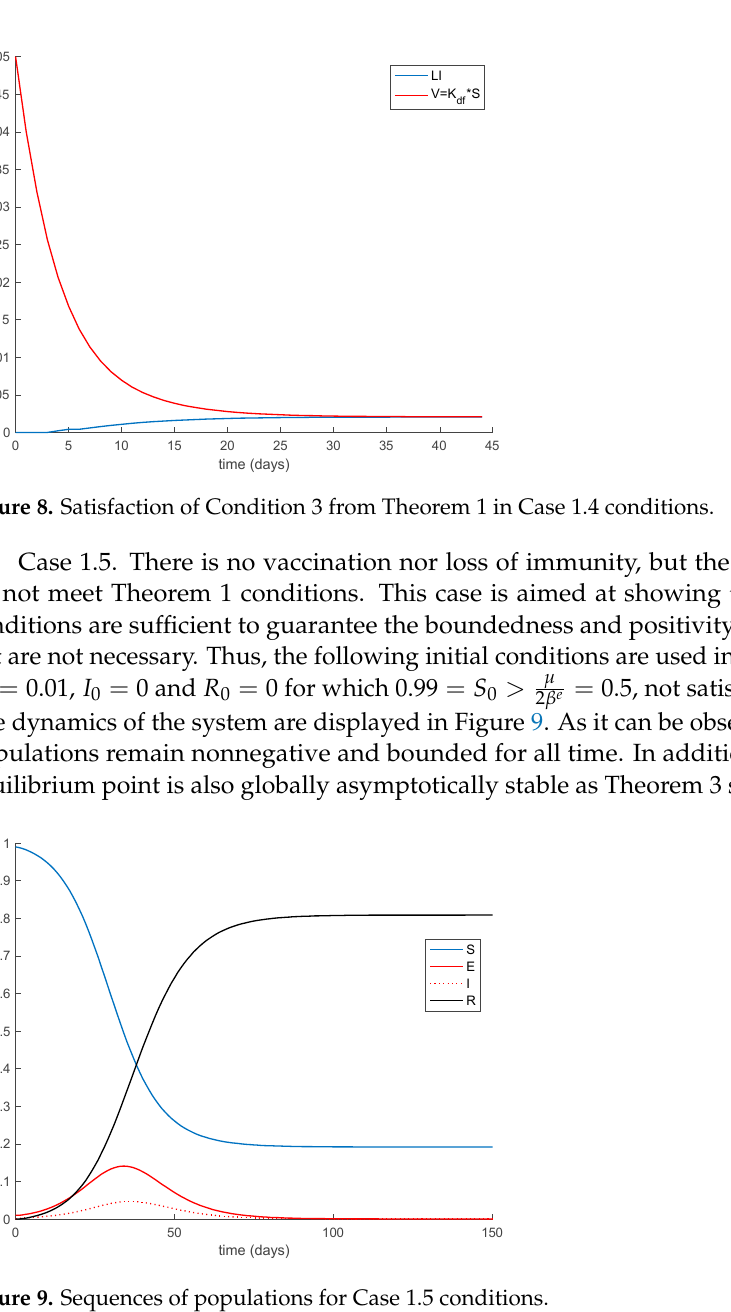
Figure 10. Sequences of populations for Case 1.6 conditions. It is observed in Figure 10 how after 180 days the loss of immunity makes some former immune individuals become susceptible again. In the end, an endemic equilib- rium point is reached. From the numerical simulation we can obtain the location of the endemic equilibrium point and compare it with the theoretical values given in Proposi- tion 2. The comparison is performed in Table 1, which shows agreement between them. Table 1. Comparison of the theoretical values predicted by Proposition 2 and the numerically ob- tained ones for the location of the endemic point. Theoretical